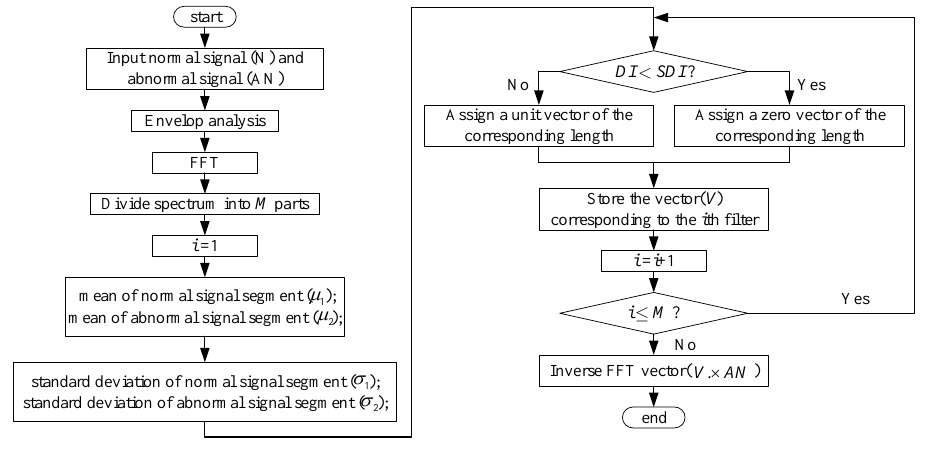
Figure 8. Detailed information for filter process.